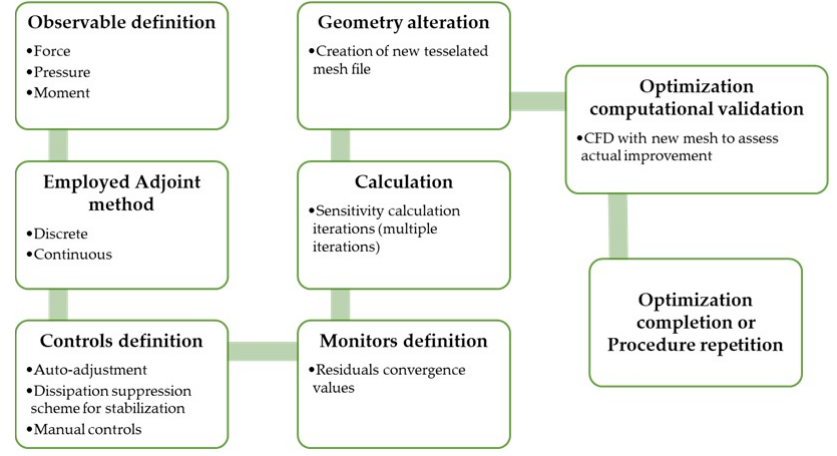
Figure 2. Adjoint Shape optimization specific workflow schematic.